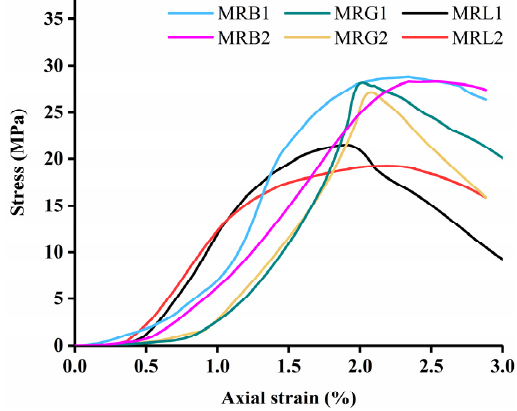
7 of 21 Table 7. Results of test. Group Peak Load (MPa) Maximum Displacement (mm) AE Characteristics MRB-1